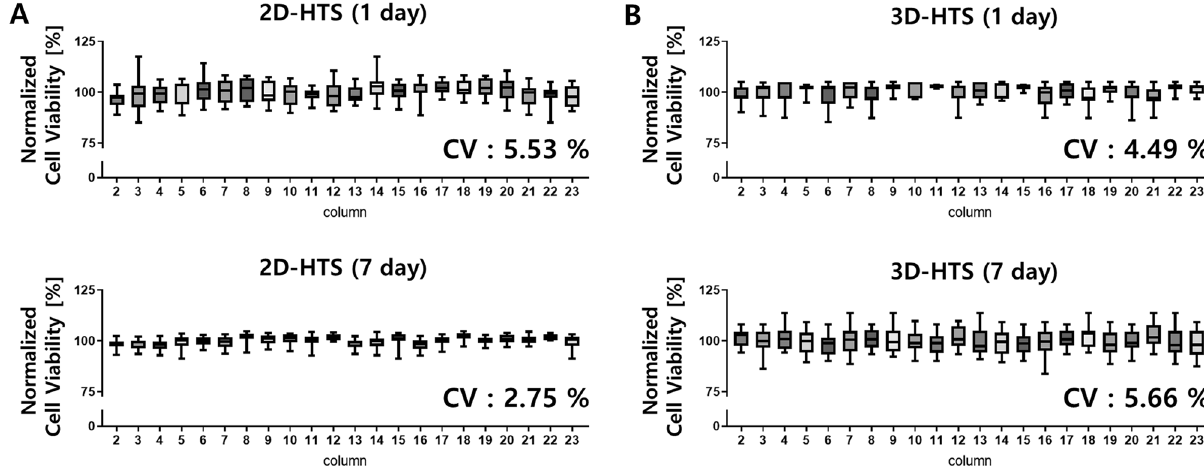
Figure 3. Quantitative analysis of cell dispensing and culture uniformity through cell viability measurement. ( A ) The uniformity CV values of the 1 and 7 days of culture after dispensing the cells in the 2D-HTS condition were 5.53% and 2.75%, respectively. (N = 308, spots excluding the edge of the 384 plate). ( B ). The uniformity CV values of the 1 and 7 days of culture after dispensing cells in 3D-HTS conditions were 4.49% and 5.66%, respectively. (N = 308, spots excluding the edge of the 384